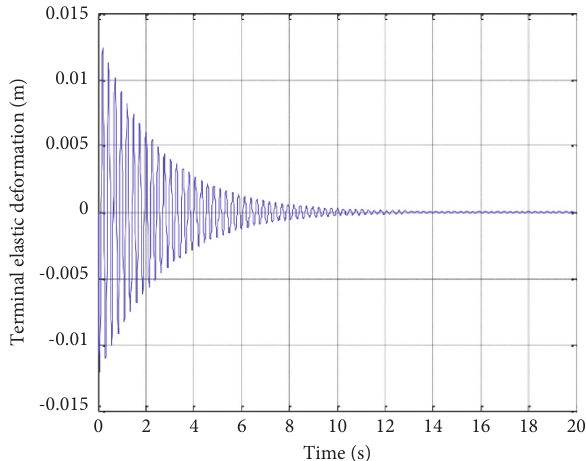
Figure 9: Tip deflection of the flexible